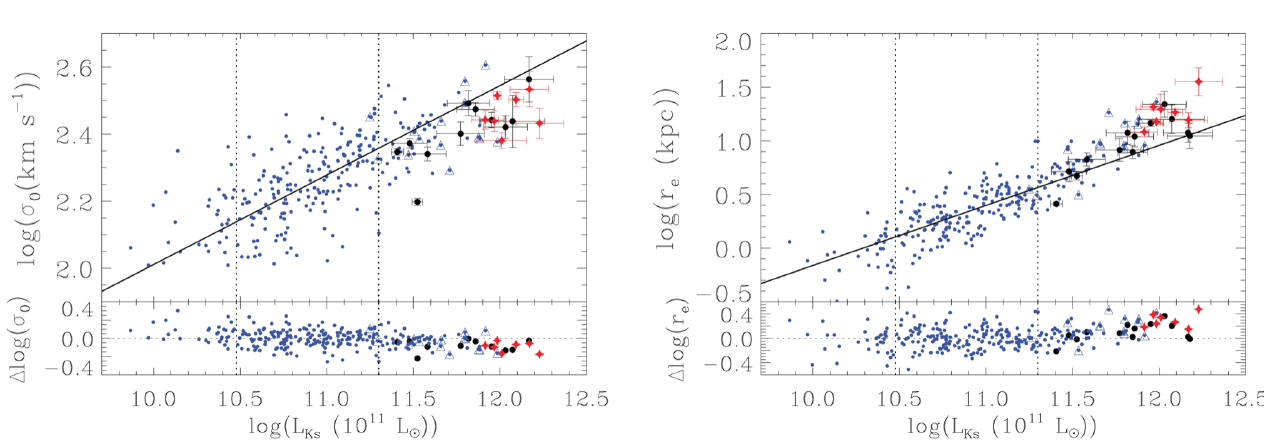
Figure 5. Left panel : distribution of the BCGs of Méndez-Abreu et al. [79] red stars and large black points and the early-type galaxies of Pahre et al. [83] small blue points in the log σ 0 vs log L ks plane. The BCGs in the Pahre et al. [83] sample are marked by blue open triangles. Right panel : same as the left panel, but in the log r e vs. log L Ks plane. The solid line represents the best fit to the galaxies in the luminosity range 3 × 10 10 < L Ks / L (cid:12) < 2 × 10 11 . The bottom panels represent the residuals from the best fit. The original image can be found in Méndez-Abreu et al. [79] and corresponds to their Figures 9 and